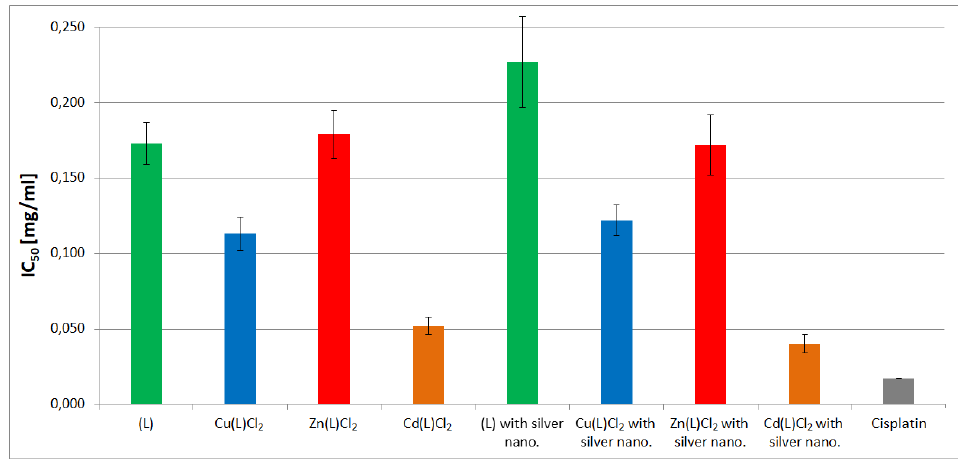
Figure 14. In vitro cytotoxic activity of new compounds on cancer cell lines (A549). The last bar presents IC 50 value for cisplatin [25] as a reference. Statistical significance was assessed using one-way ANOVA analysis. * p < 0.01 was considered as significantly different between cytotoxicity of cisplatin and tested compounds.